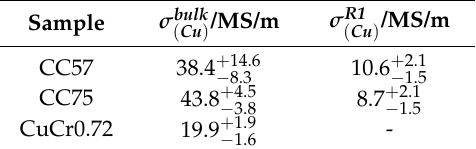
Table 3. Calculated σ (Cu) for bulk material and R1 for CC57, CC75 and CuCr0.72, respectively.